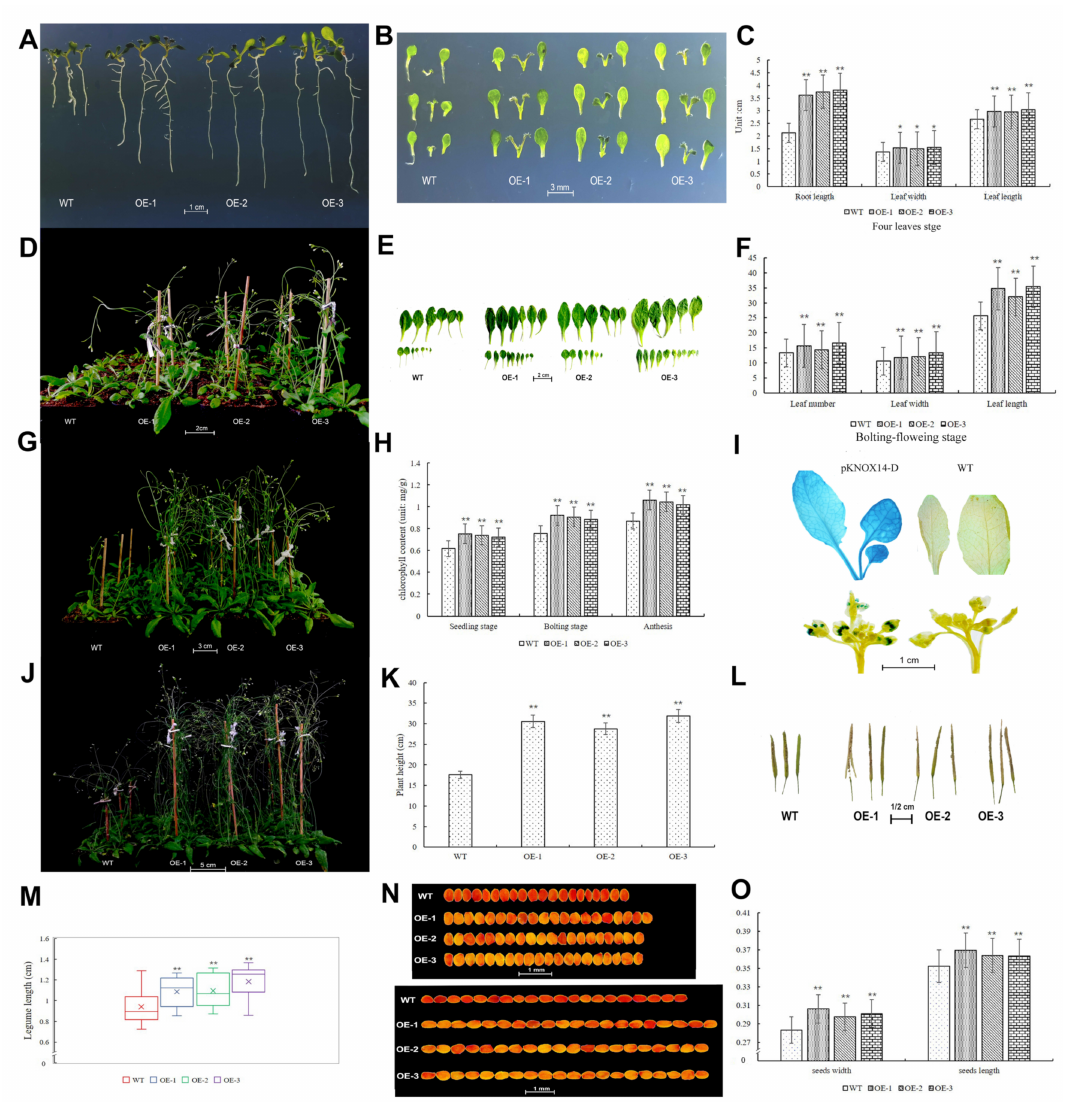
Figure 8. Phenotypes of WT and three transgenic Arabidopsis overexpressing TaKNOX14-D . ( A ) The root length of four Arabidopsis lines at the four-leaf stage, bar = 1 cm. ( B ) Leaf number and width/length at the four-leaf stage, bar = 3 mm. ( C ): Root length and leaf width and length of Arabidopsis at the four-leaf stage, 30 Arabidopsis plants were randomly selected from each line and the root length and leaf area were measured by Image J (version: 1.8.0). ( D ) Transgenic Arabidopsis at bolting stage and WT at seeding stage. ( E , F ) Leaf area and number of rosette leaves. Six Arabidopsis plants were randomly selected from each line and the leaf width and length were measured by Image J ((version: 1.8.0). ( G ) Transgenic lines at flowering stage and WT at bolting stage. ( H ) Chlorophyll content in rosette leaves, six plants of each line were randomly selected, the rosette leaves of six plants were detected with spectrophotometer and repeated three times. ( I ) GUS staining of a leaf and flower. ( J ) Arabidopsis at pod stage. ( K ) Plant height of four lines, six plants were randomly selected and plant height was measured with a ruler. ( L , M ) The pod length of four Arabidopsis lines, bar = 0.5 cm. Twenty pods located at the top of the Arabidopsis plant were collected and measured. ( N , O ) Seed length and width, bar = 1 mm. Twenty seeds were randomly chosen and the seed width/length were counted. *, p < 0.05; **, p < 0.01 (Student’s t